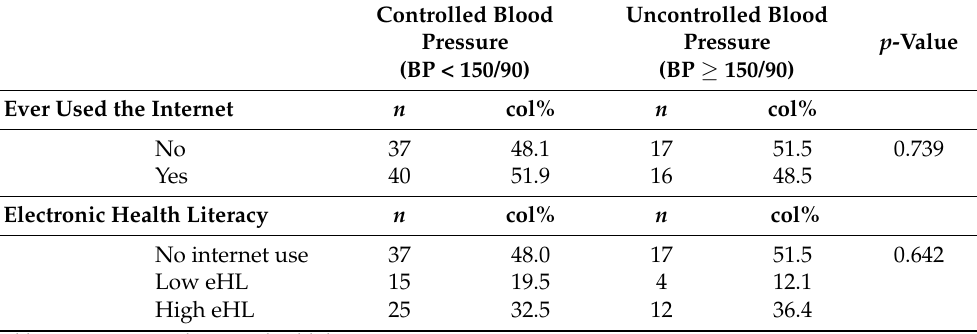
Table 4. Internet use, electronic health literacy, medication use, and blood pressure control ( n = 110).